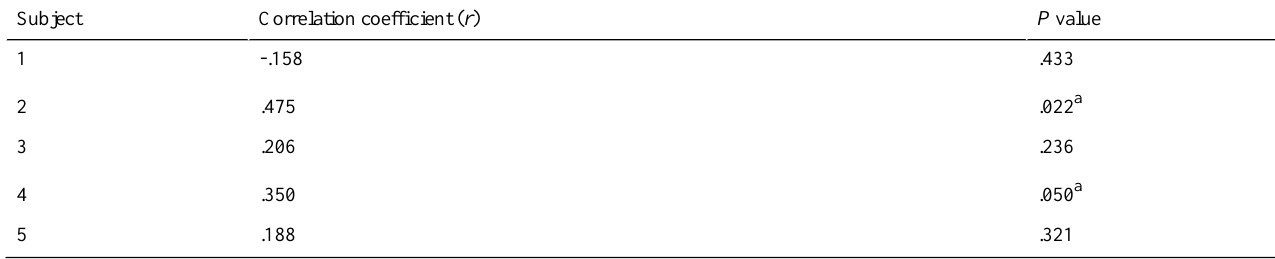
Table 1. Total hours of sleep/rest the previous night correlated with medication-taking adherence the next day.